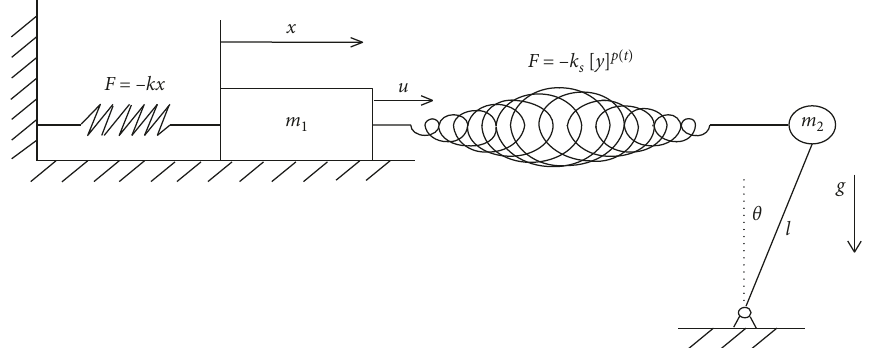
Figure 1: The underactuated, weakly coupled, and unstable system.